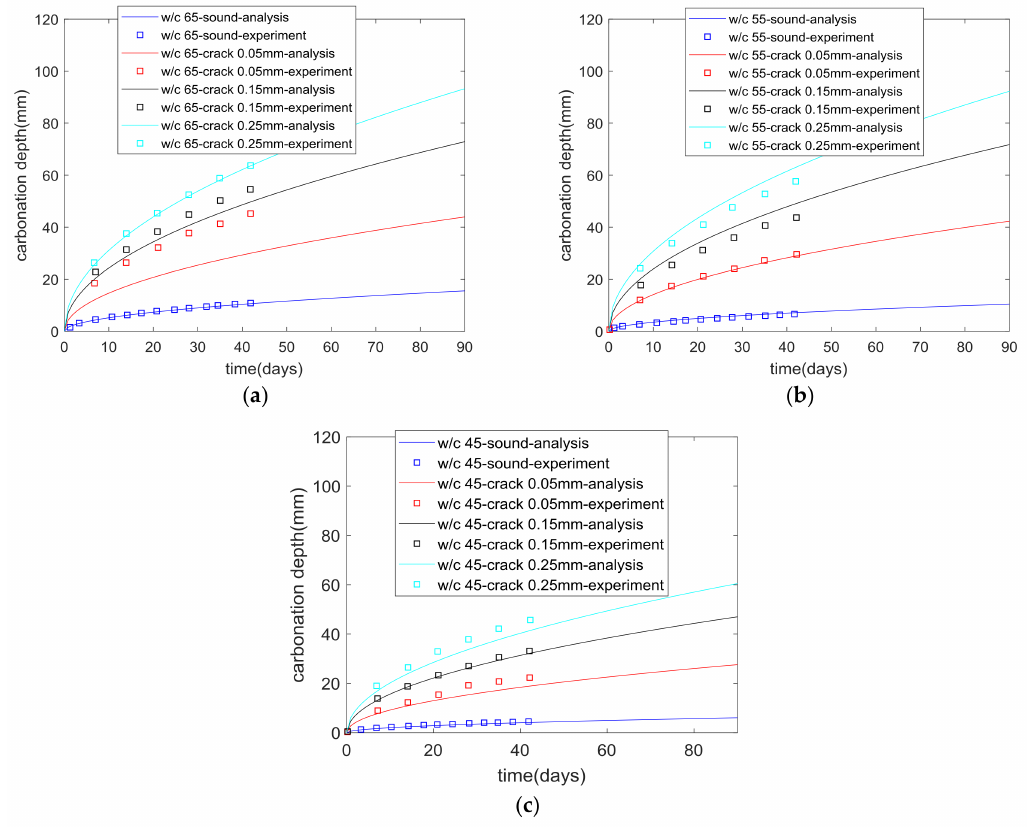
Figure 5. Carbonation depth of cracked concrete. ( a ) W/C 0.65; ( b ) W/C 0.55; ( c ) W/C